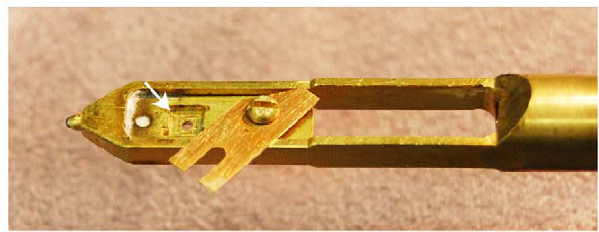
Figure 4. Picture of the tip of the modified specimen holder (Hitachi type). The liquid enclosure fits into the slot indicated by the arrow. A metal blade and a screw serve to fix the liquid enclosure in place.